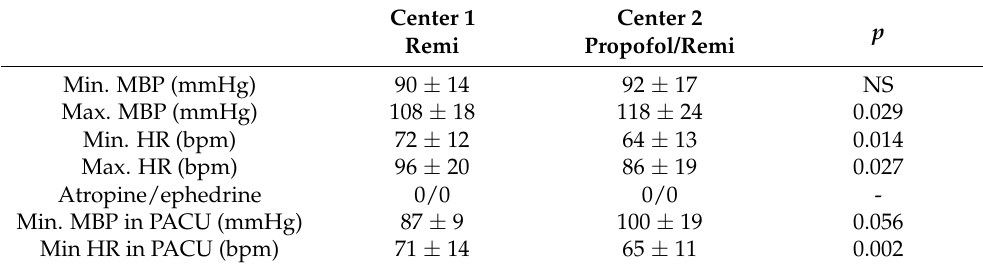
Figure 1. Minimal respiratory rate as a function of total dose of propofol received (1 point/patient). Higher propofol doses were significantly correlated with lower minimal respiratory rates (r = − 0.25). Table 4. Cardiovascular monitoring. Mean ± standard deviation or number of patients.